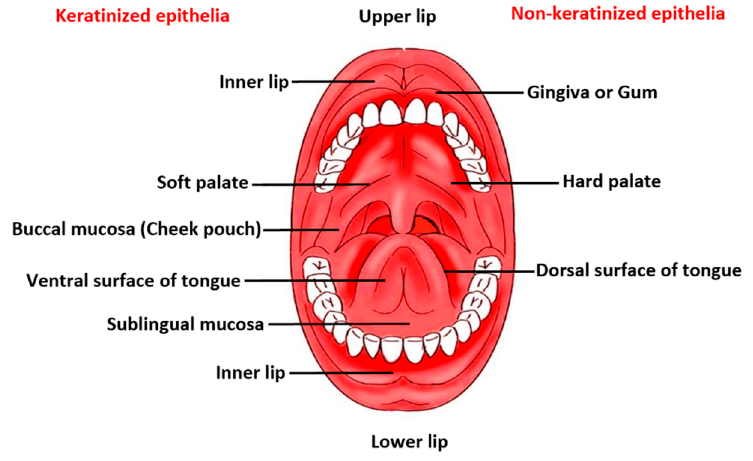
Figure 1. A schematic diagram depicting the key regions of the buccal